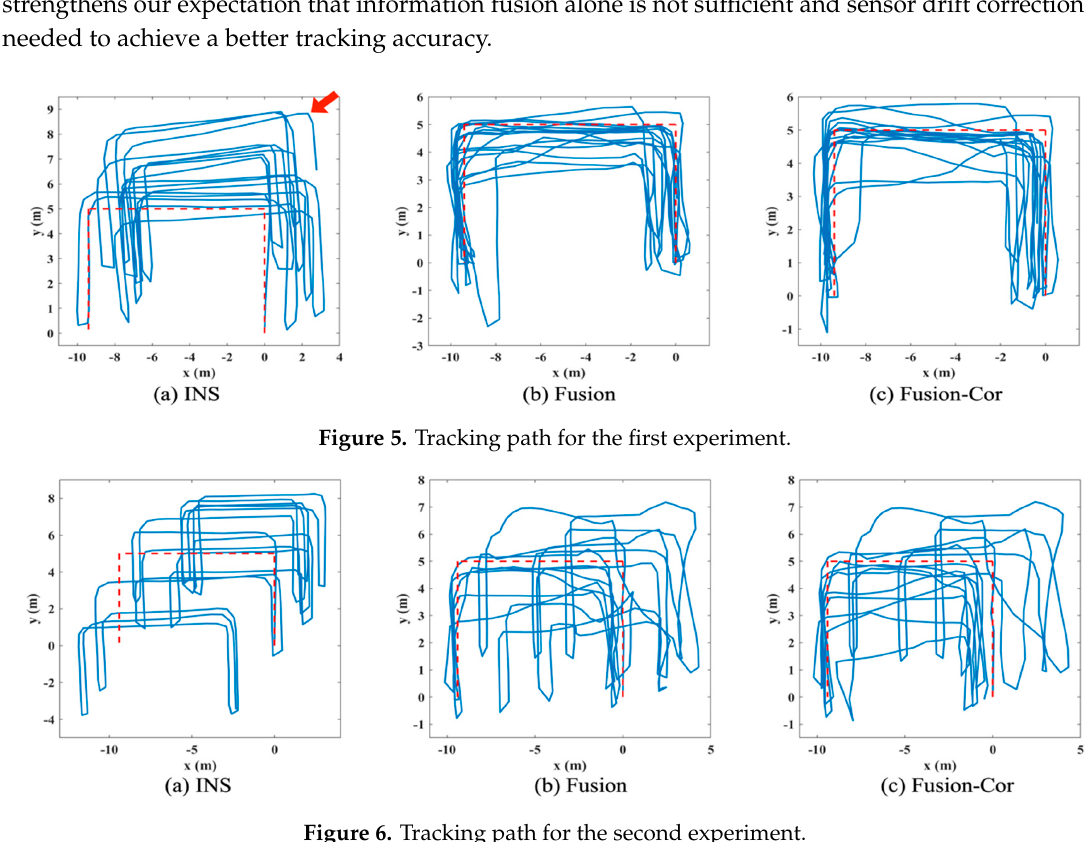
Figure 7. Cumulative distribution function (CDF) of position error. Table 3. Mean position error. INS